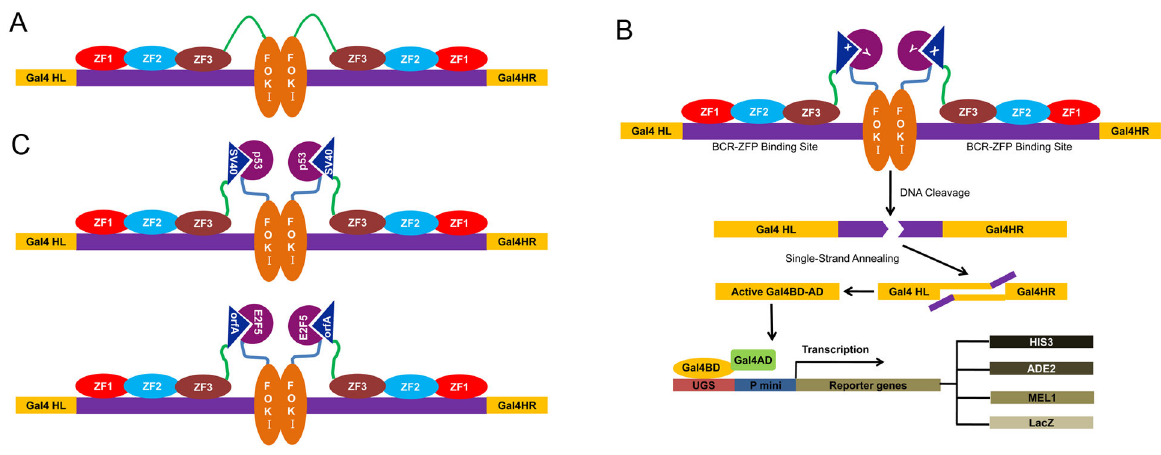
Figure 1. Schematic diagram describing the zinc finger nuclease yeast two-hybrid (ZFN-Y2H) system to identify protein– protein interactions. (A) Traditional ZFNs are composed of a fused protein of a zinc finger DNA-binding domain (ZFP) and a non- specific nuclease domain (FokI), in which ZFPs recognize binding sites and recruit dimers of FokI to cleave DNA specifically and highly efficiently. (B) A known protein partner X is expressed as a fusion protein with BCR-ZFP for the bait, and another known protein Y or cDNA library is fused with FokI as the prey. When proteins X and Y interact with each other, FokI is recruited as a dimer to cleave a target site within Gal4 and generate double-strand breaks (DSBs), which could be repaired by single-strand annealing (SSA). Thus, a functional Gal4 DNA-binding domain (DBD) and activation domain (AD) are restored, which drives the expression of reporter genes. (C) Illustration of p53-SV40LT and WDSV orfA-E2F5 interactions in this Y2H system. doi: